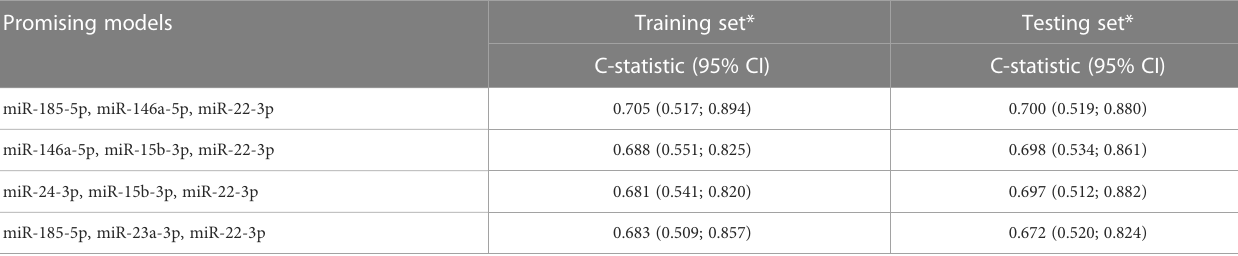
TABLE 2 Prognostic performance of the promising models. Promising models